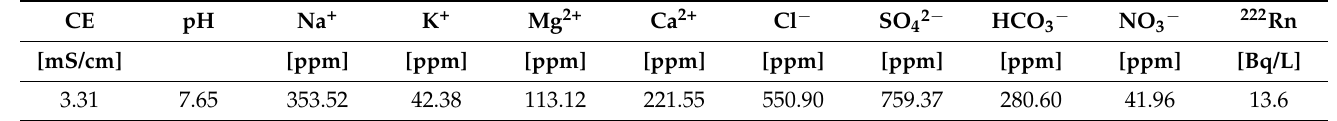
Figure 2. Temporal evolution of CO 2 (ppm) and 222 Rn (Bq/m 3 ) concentrations, outdoor ( ◦ C) and indoor ( ◦ C) temperature, outdoor (%) and indoor (%) relative humidity and precipitation (mm). Events of high outdoor humidity (>75–80%) are marked. Table 1. Electrical conductivity (CE), pH and chemical composition of